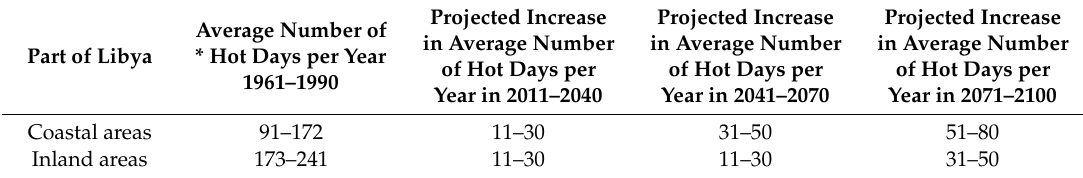
Table 8. Regional projections of hot days per year in Libya (adapted from [39]).